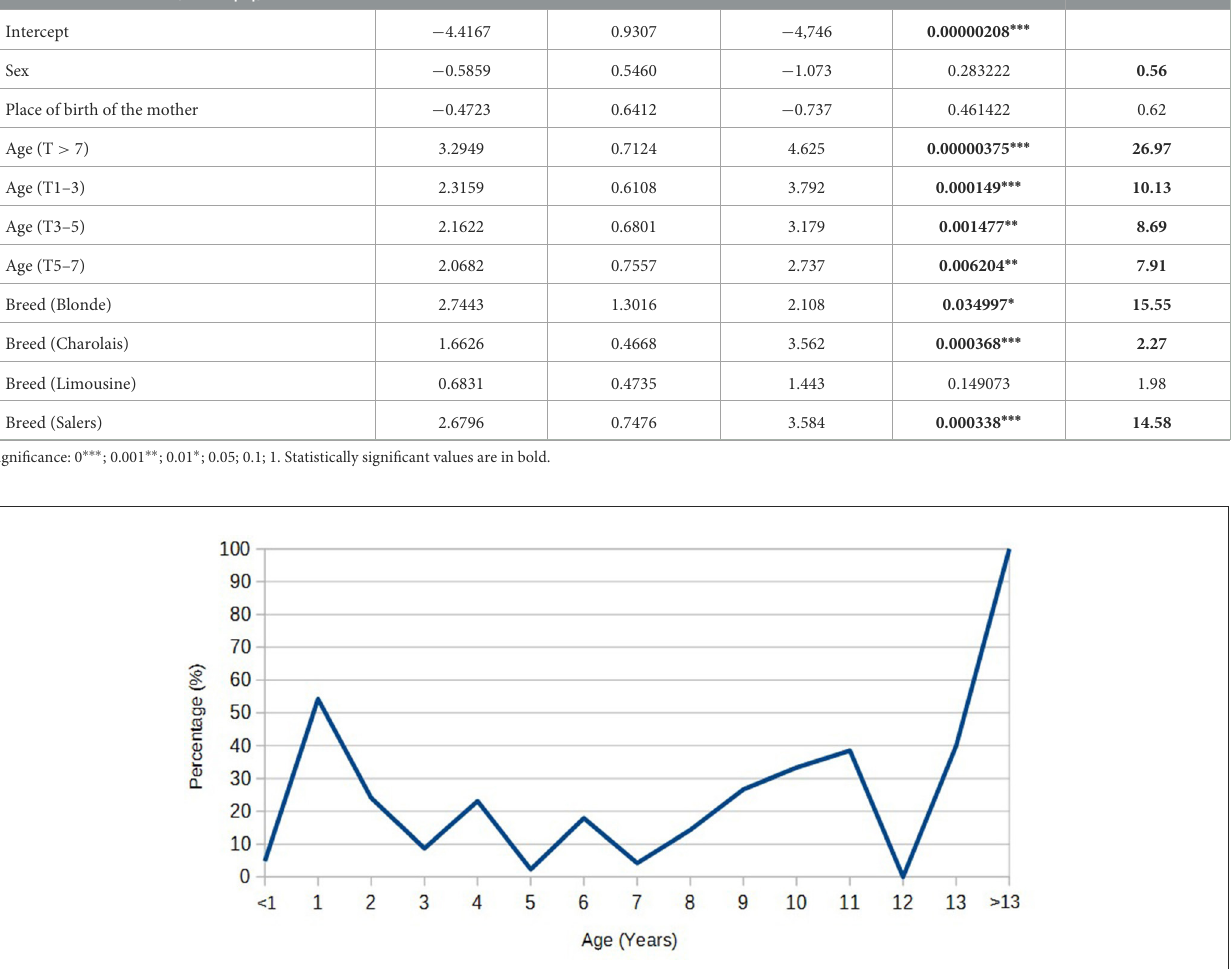
TABLE 2 Statistical results from the logistic regression: estimate error, significant variables, and odds ratio (95% confidence interval) according to the independent variables sex, place of birth of the mother, age, and breed. Estimate error z (Pr > | z |)